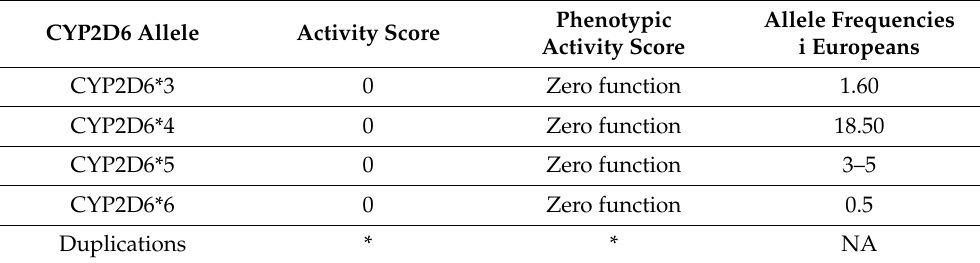
Table 2. Activity score for analyzed CYP2D6 alleles and their frequencies in Europeans [23]. CYP2D6 Allele Activity Score CYP2D6*3 0 Zero function 1.60 CYP2D6*4 0 Zero function 18.50